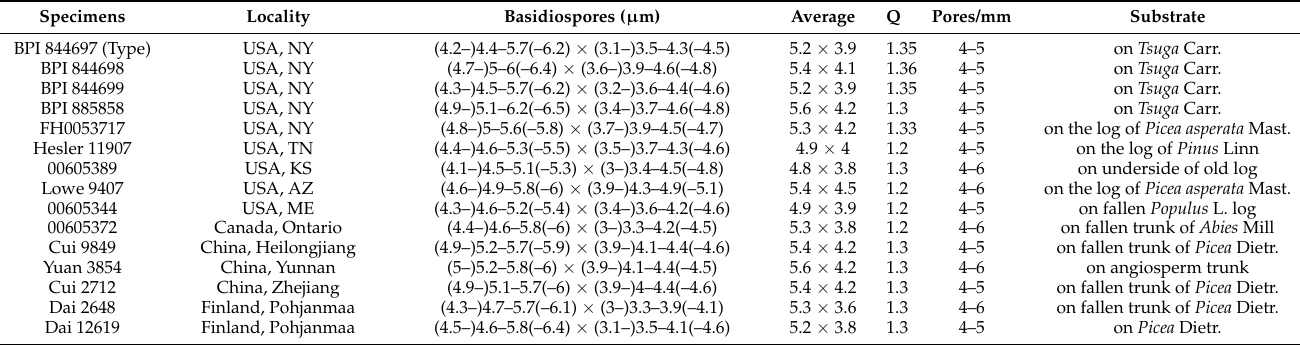
Table 3. A list of characteristics of Poriella subacida comb. nov. from different